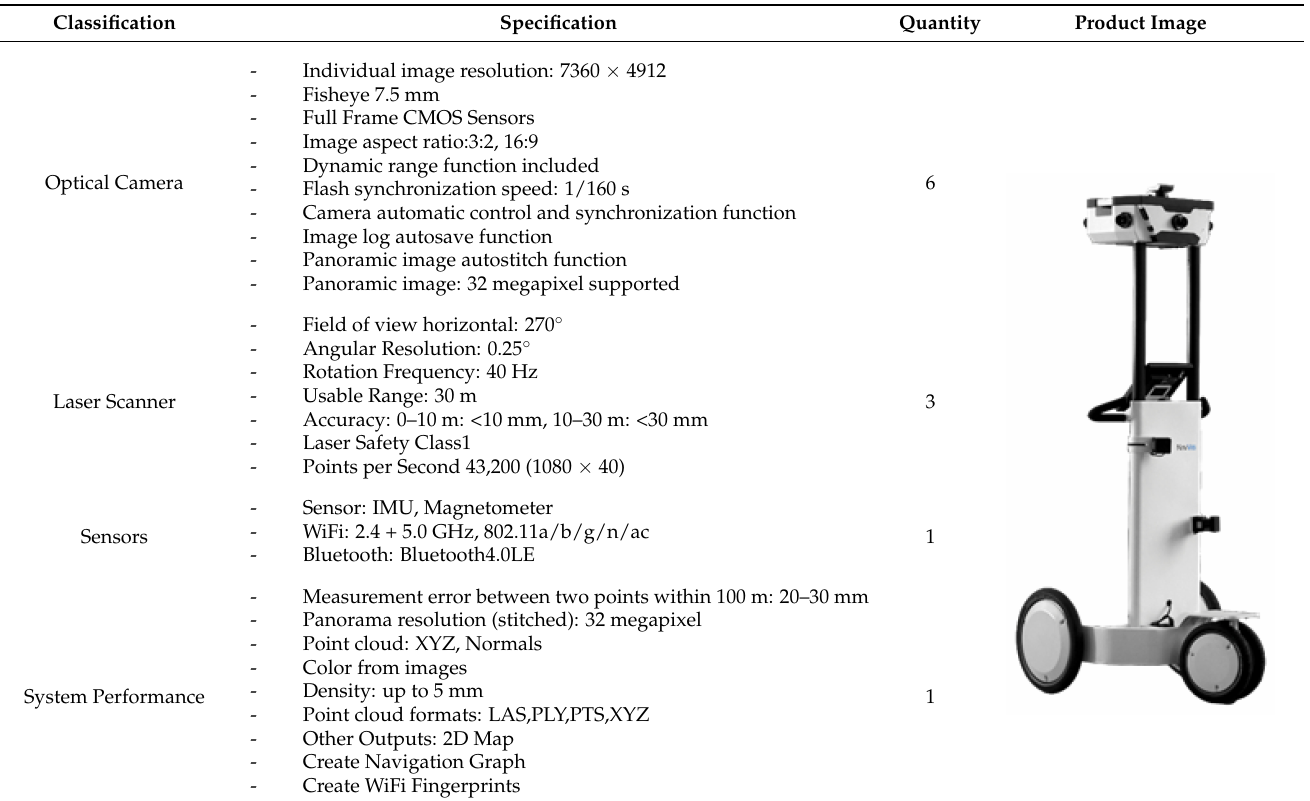
Table 1. Characteristics of surveying equipment.